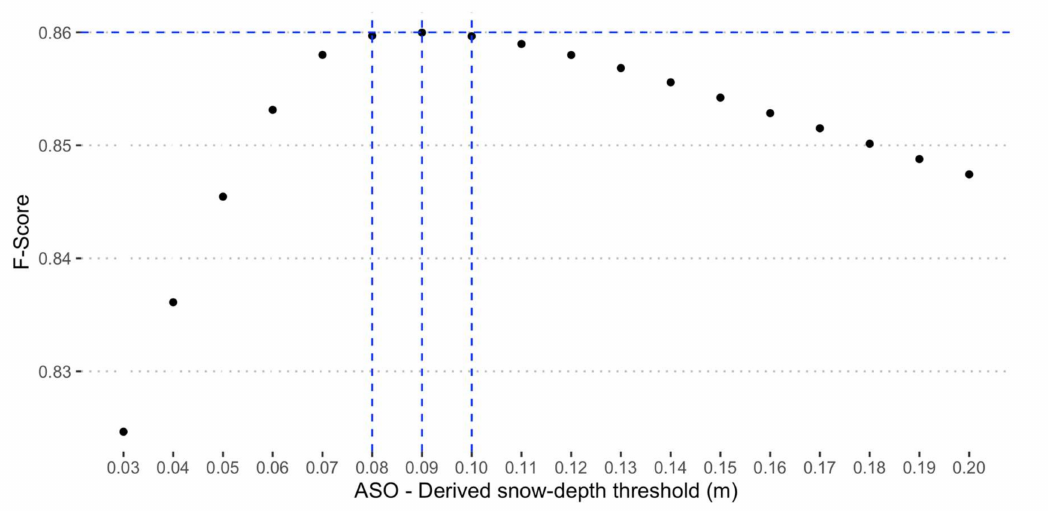
Figure 9. Model performance of DEM with derived attributes model when the lidar-derived threshold for snow cover was varied from 3 cm to 20